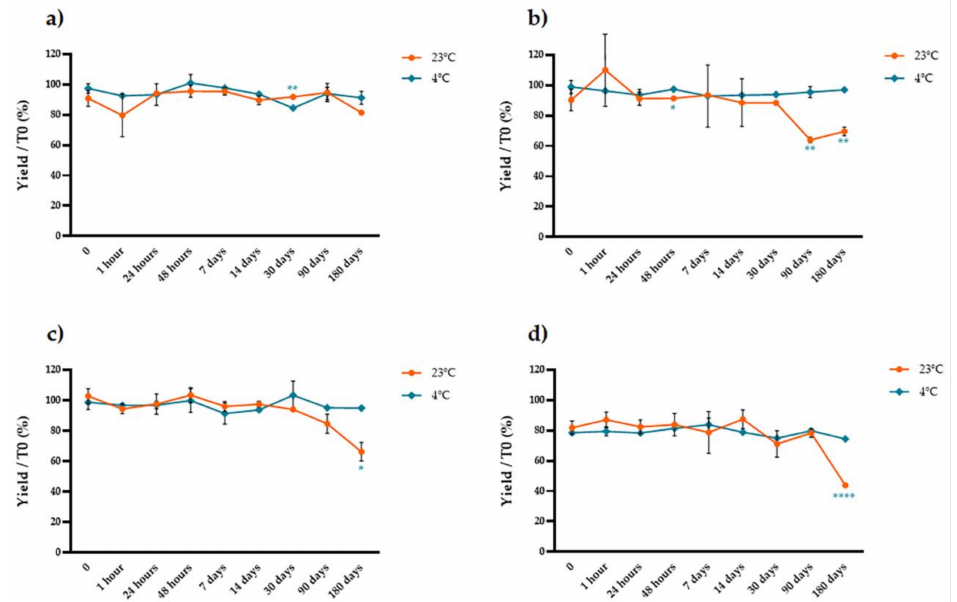
Figure 8. Stability over time of lyophilized extracts prepared with different solvents and stored at 23 ◦ C (blue line) or 4 ◦ C (red line). The samples were extracted with ( a ) water, ( b ) 12.5% ethanol, ( c ) 25% ethanol, and ( d ) 50% ethanol before lyophilization. The y axis shows the yield as a percentage relative to the samples that were analyzed immediately after extraction. Significant differences between the two storage temperatures are indicated with asterisks (* p < 0.05, ** p < 0.01, *** p < 0.001, **** p < 0.0001). Data are means ± SD ( n = 3 independent experiments; multiple t -tests with Holm– Šid á k correction, p <